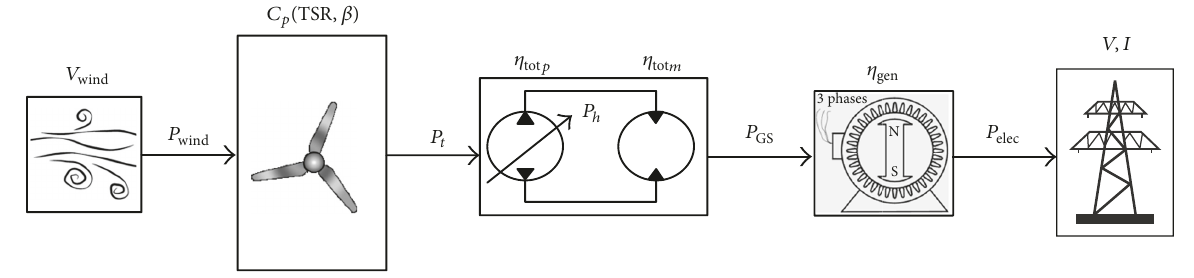
Figure 2: Power flow through the